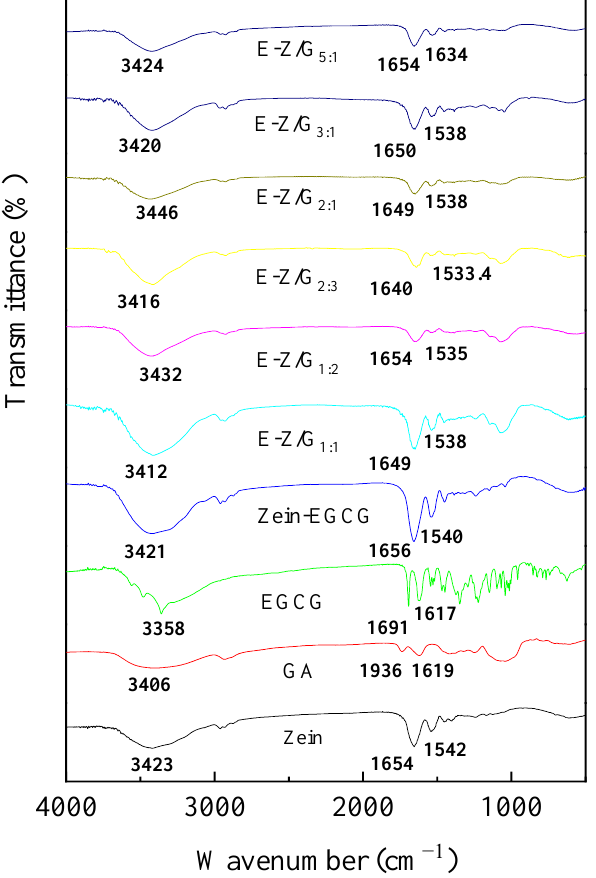
Figure 4. The infrared spectra of different samples.